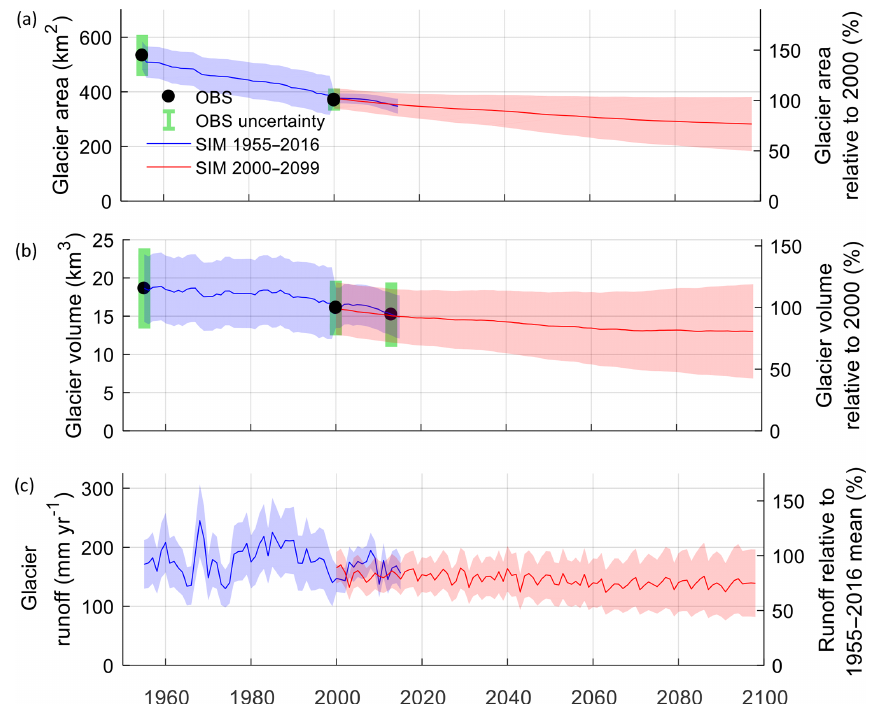
Figure 9. Variations in (a) ice volume, (b) glacierized areas, and (c) glacier runoff in the Maipo River basin for the past period (1955– 2016) and the committed ice loss scenarios assuming a constant climate. In (a) and (b) we use results from the glacier inventories and the combination of ice thickness estimates and geodetic mass balances, respectively, as observations of glacier area and volume. Glacier runoff in (c) is computed for the Maipo River basin (i.e., runoff units are normalized by the basin area). While the uncertainty bars of the observations are shown in green, those of the simulations are shown in blue for the 1955–2016 period and in red for the committed ice loss scenarios. For visual purposes, we present the committed ice loss scenarios using the period 2000–2100 in the x